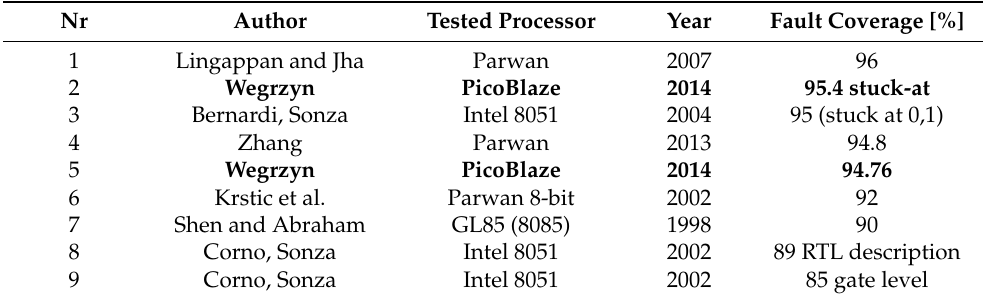
Table 1. Summary of results of research from the bibliography in comparison with